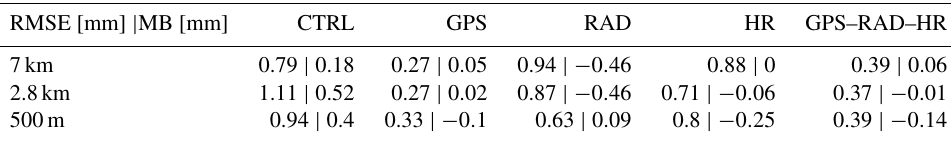
Table 2. Root-mean-square error (RMSE; left) and mean bias (MB; right) of spatially and temporally averaged IWV between GPS and COSMO (22 September to 25 September 00:00UTC) over RhoAlps. The averages are obtained from hourly IWV values, at the GPS station locations. The COSMO simulations have been coarse-grained to a common grid of 8km grid spacing for this comparison. And a height correction on model data based on Bock and Parracho (2019) has been